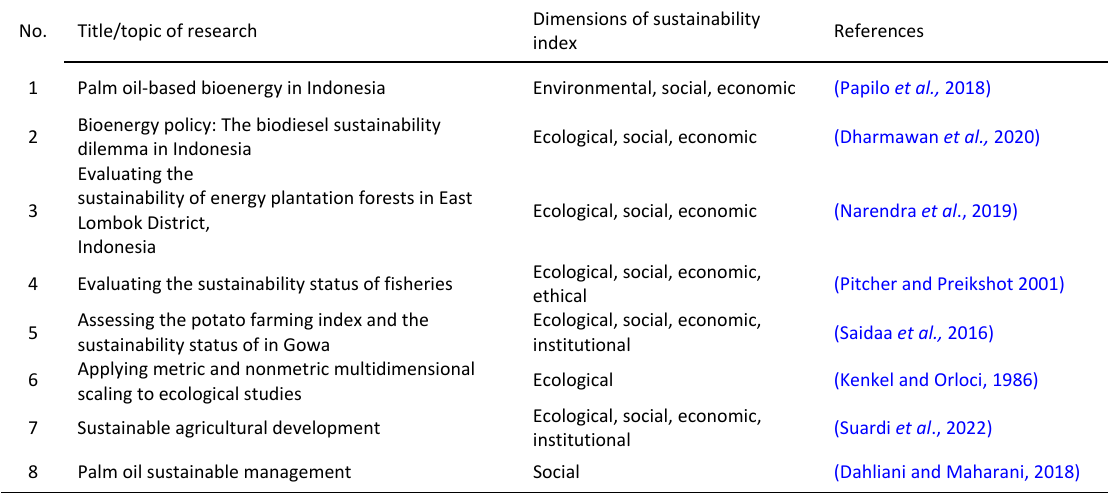
Table 2: Previous studies using MDS analysis